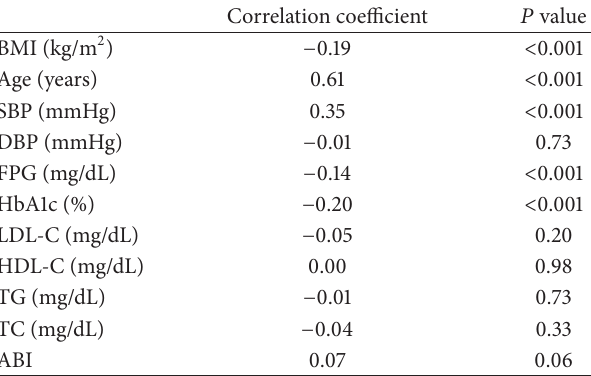
Table 2: Relationship between PWV and clinical factors by Spear- man’s